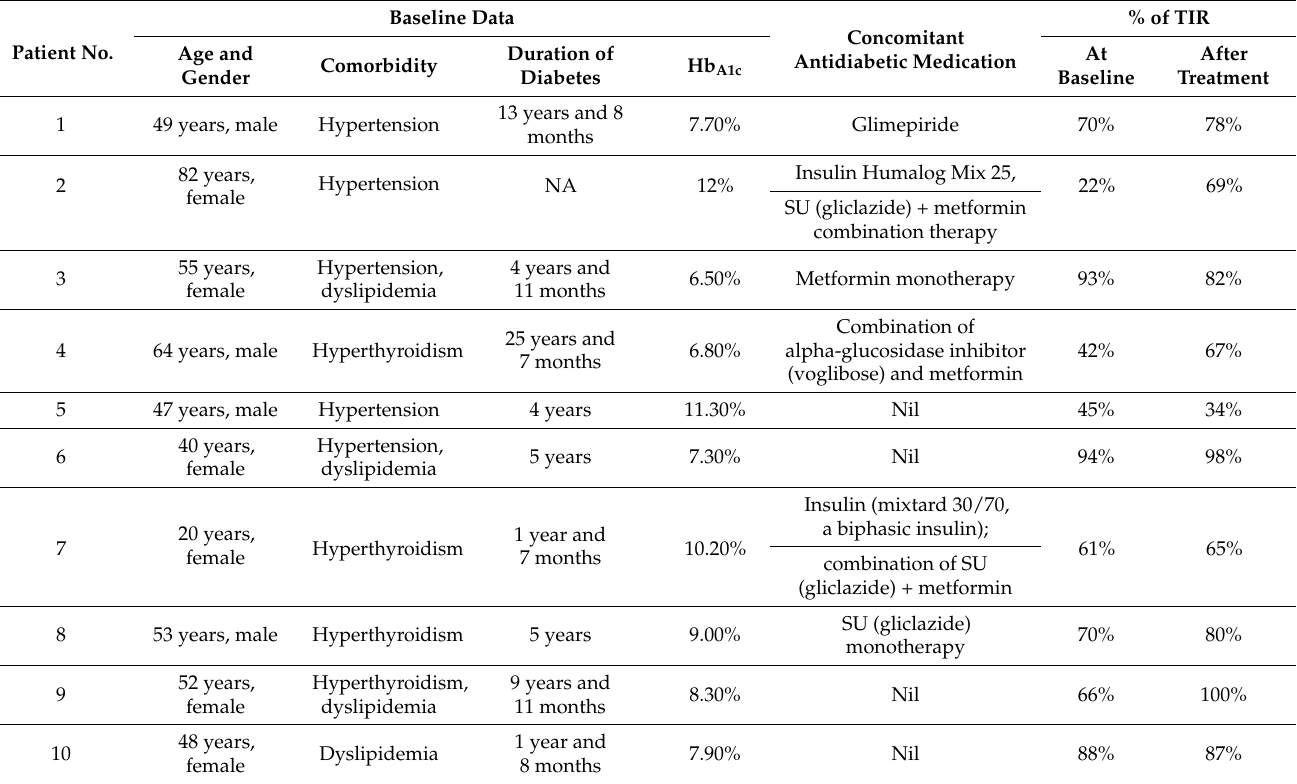
Table 1. Details of the case reports and real-world effectiveness of metformin SR–vildagliptin FDC treatment in patients with